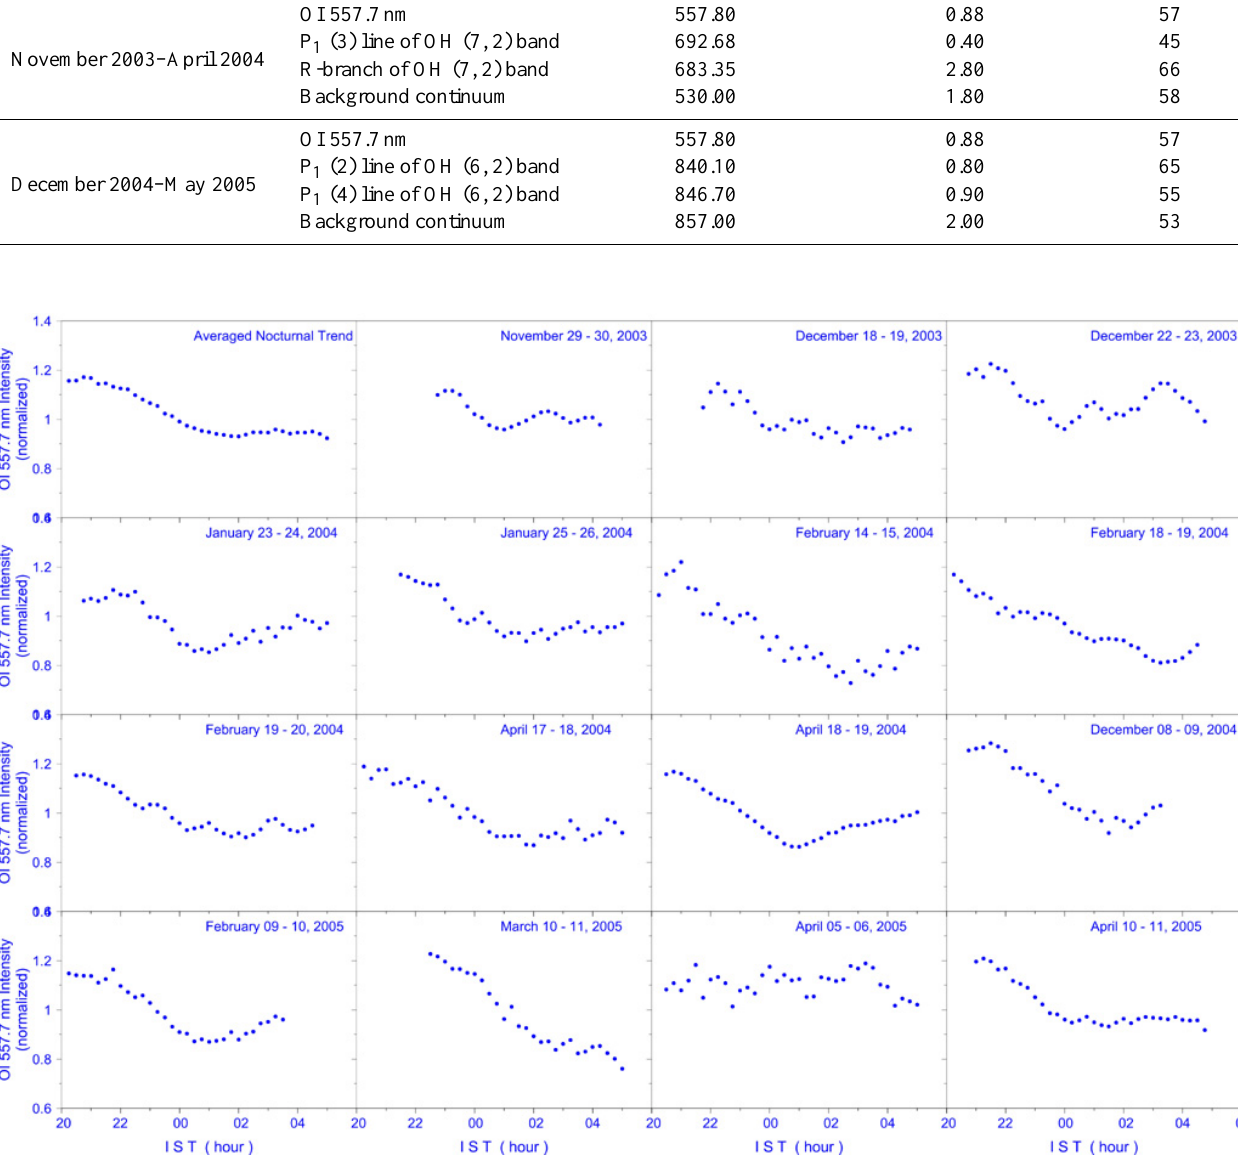
Fig. 1. Nocturnal variation (in IST) of OI 557.7nm emission intensity at